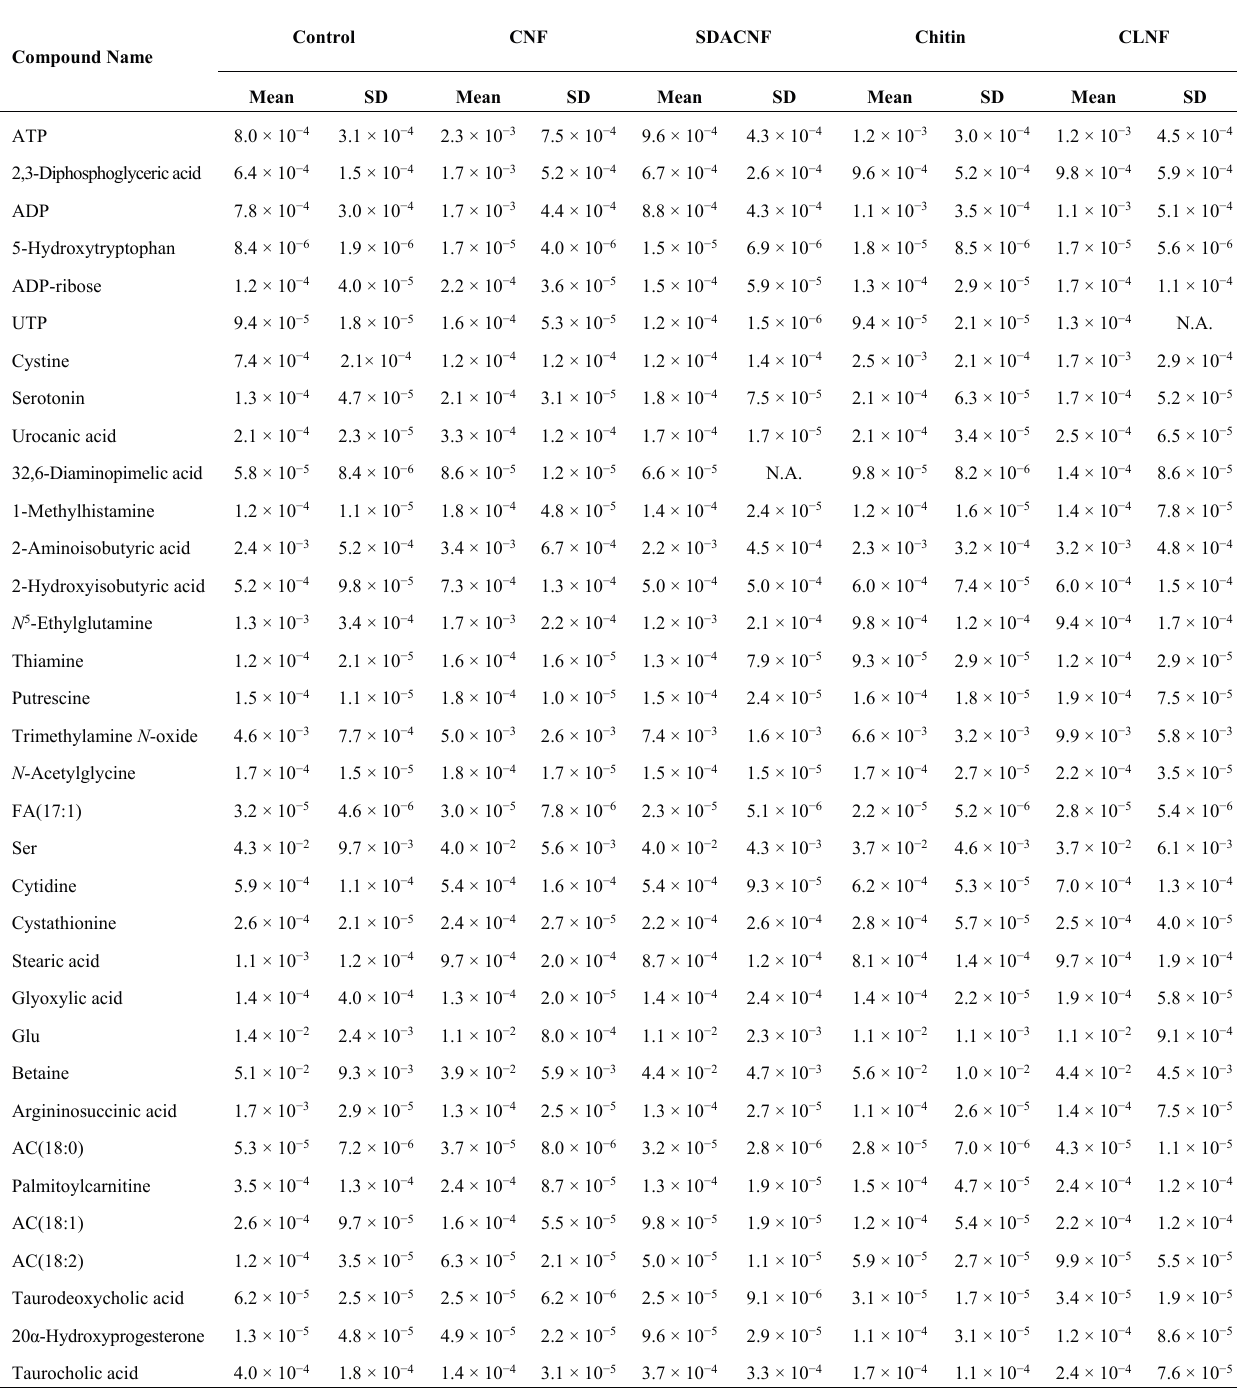
Table 2. Relative areas of plasma metabolite among experimental